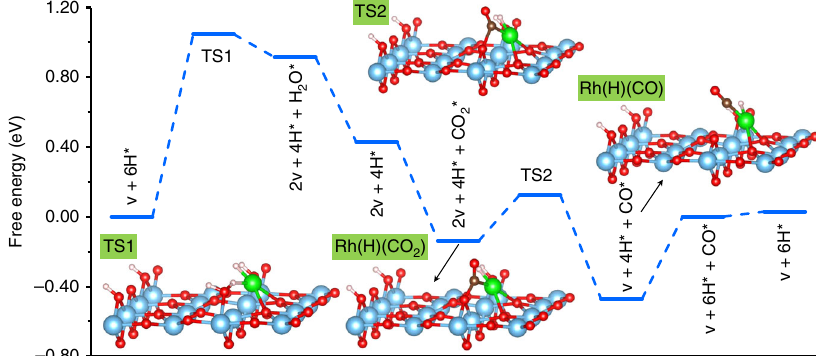
Fig. 6 Free energy pro fi le of the RWGS reaction on the Rh single atom. The supported structure of the Rh atom 6H/Rh 1 /TiO 2 − x and the dissociation mechanism are considered. The fi rst steps correspond to water formation and additional O-vacancy creation, followed by easy activation of CO 2 forming CO. Color code: O — red; Ti — blue; Rh — green. T = 500 K and pressure in experimental conditions at equilibrium are used to evaluate free energies (Supplementary Table 1). The rate controlling intermediate is the supported Rh(H)(CO) unit. Atom color code: O — red; Ti — blue; Rh